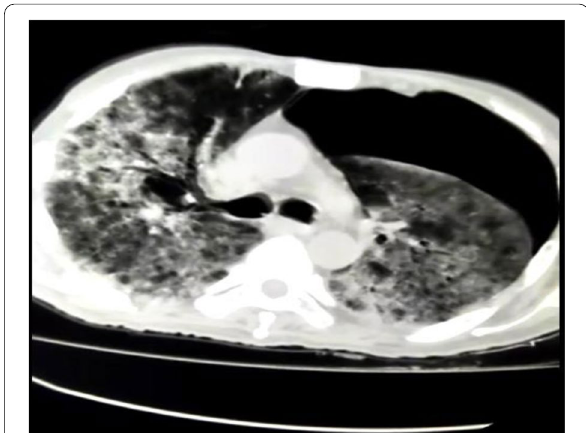
Fig. 3 Large left-sided pneumothorax with typical COVID-19 lungs